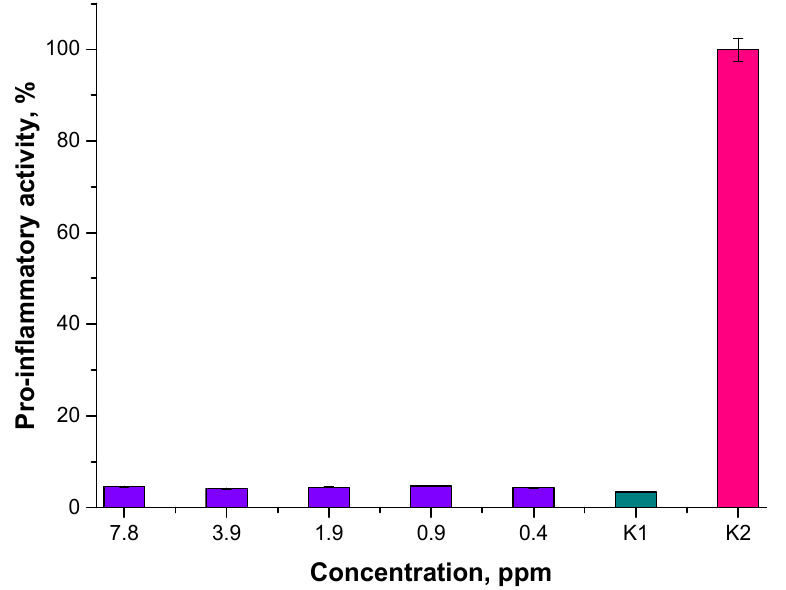
Figure 15. Analysis of the pro-inflammatory activity of Fe 3 O 4 @Au nanoparticle suspensions prepared in the water environment.